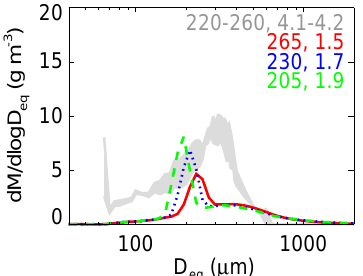
Figure 17. Particle size distributions of fluffy ice at − 40 ◦ C for simulations as in Fig. 16 with baseline updraft and pseudo-Hallett– Mossop sources of 1 (red solid line), 2 (blue dotted line), and 3stdcm − 3 (green dashed line).